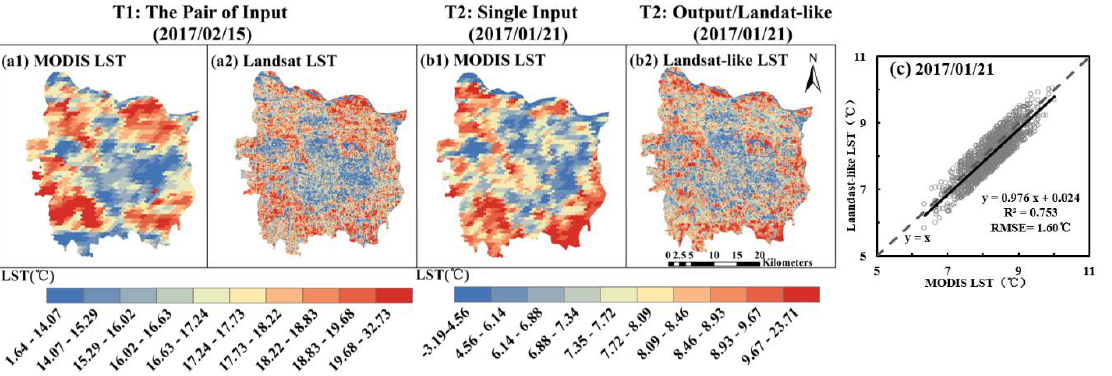
Figure 5. Spatial variations of LULC in Zhengzhou on four dates.